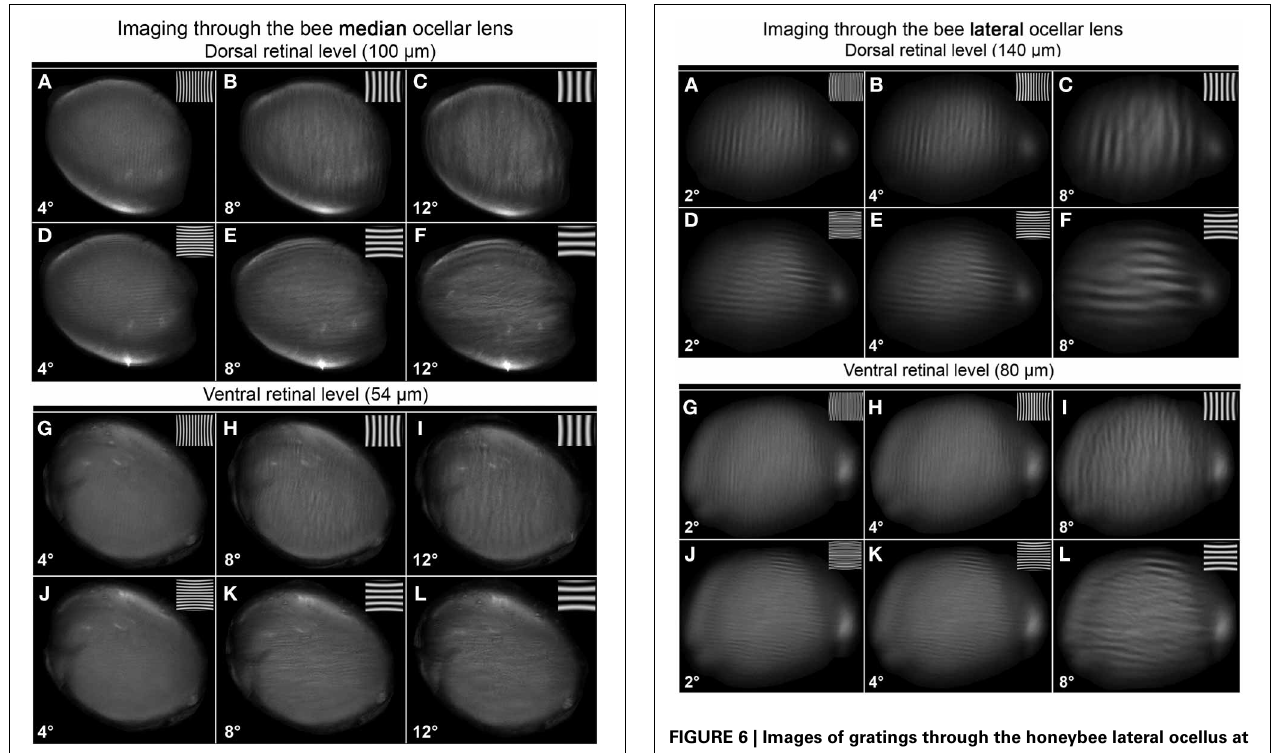
FIGURE 5 | Images of gratings through the honeybee median ocellus at the dorsal retinal level (A–F; 100 µ m away from the back of the lens) and ventral retina (G–L; 54 µ m away from the back of the lens). Spatial wavelength: ADGJ: 4 ◦ ; BEHK: 8 ◦ ; CFIL: 12 ◦ .